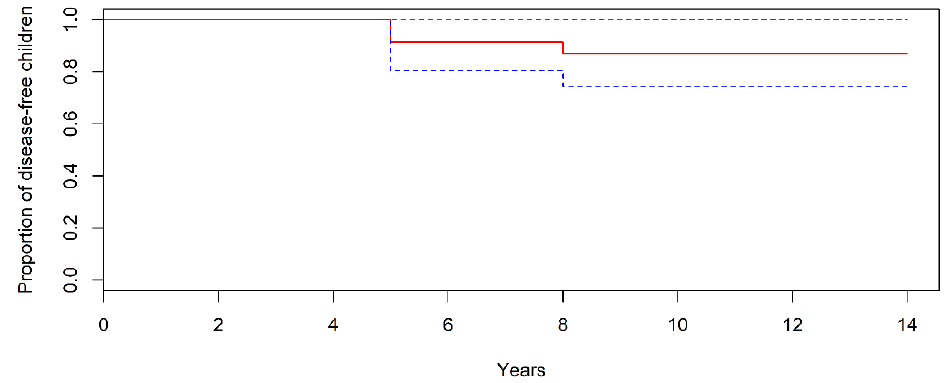
Figure 2. Kaplan–Meier Estimates of Overt Celiac Disease in Children with Potential Celiac Disease According to Age. Dashed lines represent 95% confidence intervals.